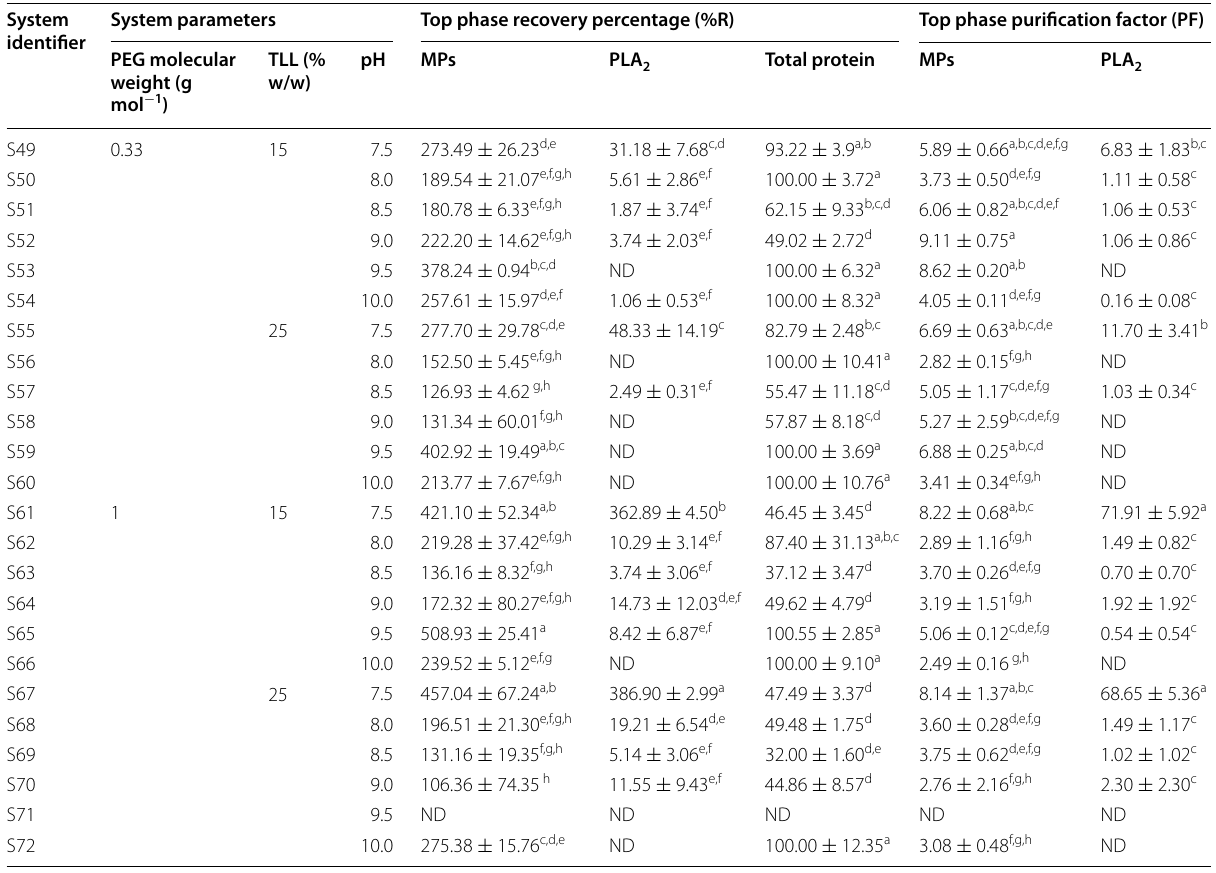
When the enzymatic activity was too low to be quantified, non‑detected (ND) is indicated. Values in the same column with different letters are significantly different ( p < 0.05)